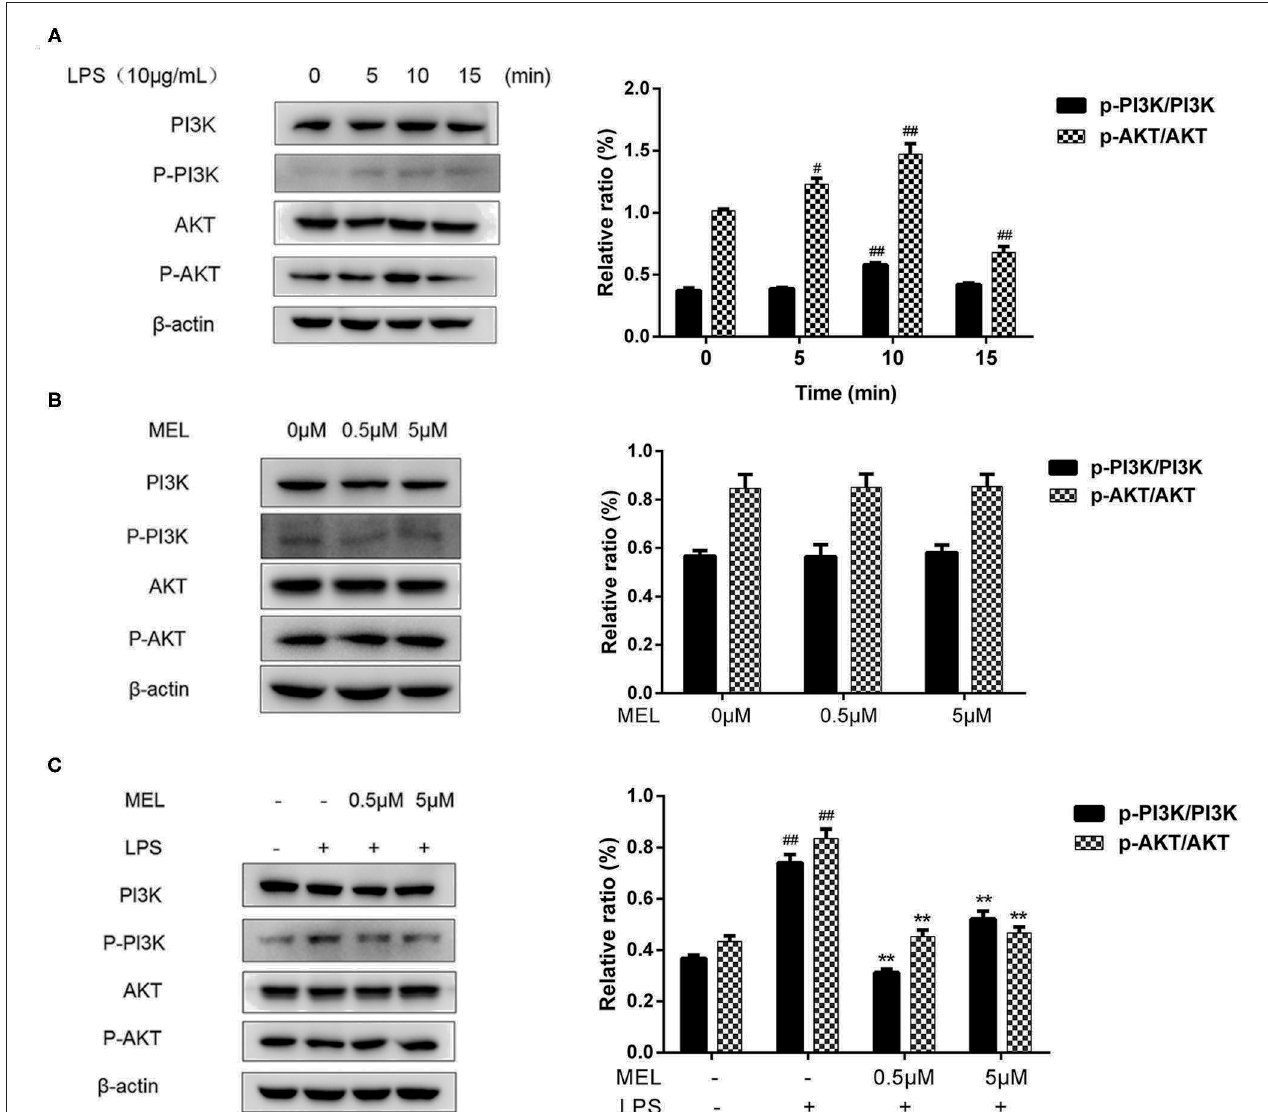
FIGURE 11 | The effect of meloxicam on PI3K and AKT phosphorylations in bovine endometrial epithelial cells. LPS, lipopolysaccharide; MEL, meloxicam. The p-PI3K, PI3K, p-AKT, and AKT levels were determined using western blot. The band intensity quantification was analyzed by Quantity One software. β -Actin was used as the internal control. (A) The cells were treated with LPS for 0, 5, 10, and 15min. (B) The cells were treated with MEL (0.5 and 5 µ M) for 10min. (C) The cells were treated with LPS or co-treated with LPS and MEL (0.5 and 5 µ M) for 10min. # P < 0.05, difference compared with the control; ## P < 0.01, difference compared with the control; * P < 0.05, difference compared with the LPS treatment group; ** P < 0.01, difference compared with the LPS treatment group. All data were presented as means ± SEM ( n =